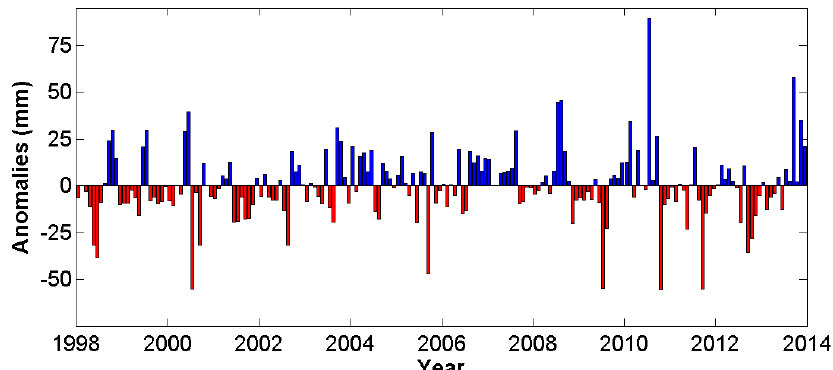
Figure 3. Spatially averaged monthly anomalies of precipitation in Mexico (1998–2013) derived from the TRMM 3B42 product.